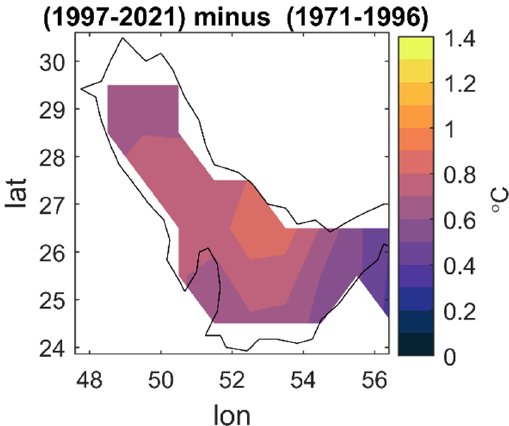
Figure 4. The SST difference between pre- and post-1996.